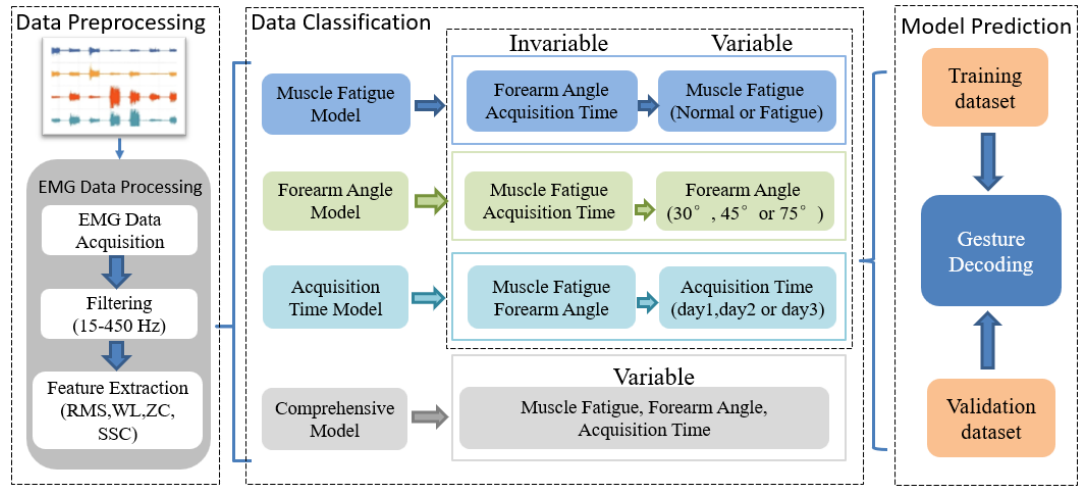
Figure 8. Block diagram of proposed learning framework.